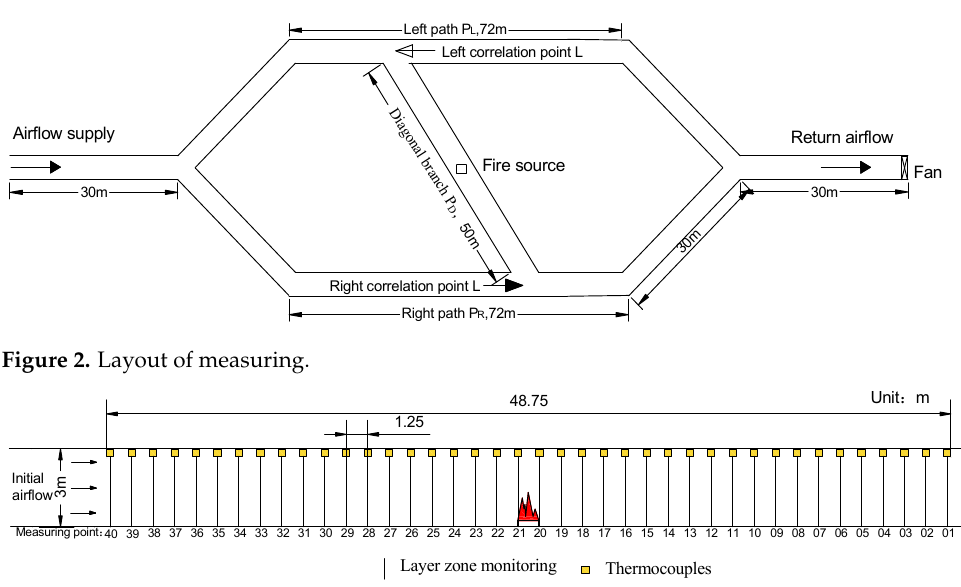
Figure 3. Layout of measuring points in the longitudinal section of the diagonal branch.